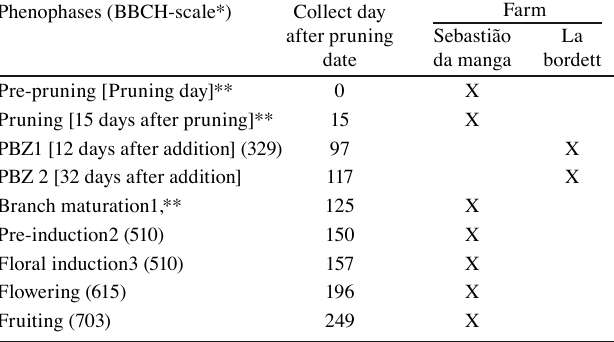
Tab. 2: Collect schedule of mango leaves and roots for analyses of nitrate reductase activity, considering the pruning event as the beginning of the cycle and their respective phenophases, in two farms with similar orchards in age and management. Phenophases